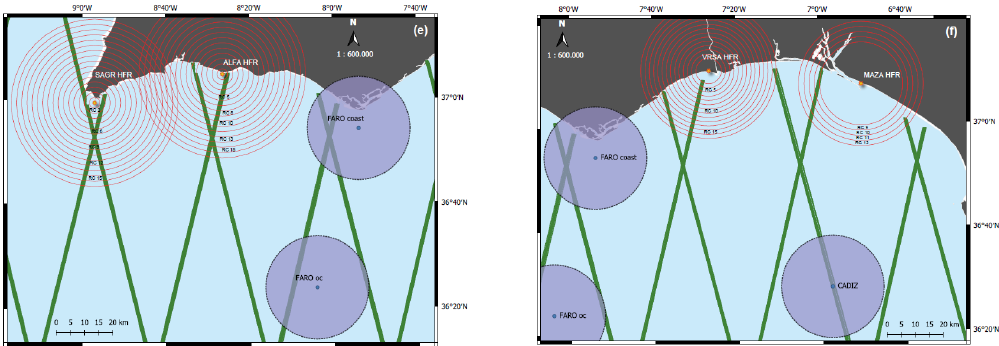
Figure 2. Wave data HFR coverage area. ( a ) VILA and FIST HFRs (RCr = 5.1 km); ( b ) PRIO HFR (RCr = 5.1 km); ( c ) SILL HFR (RCr = 5.1 km); ( d ) SJUL HFR (RCr = 1.85 km) and ESPL HFR (RCr = 2.15 km); ( e ) SAGR and ALFA HFRs (RCr = 1.85 km) and ( f ) VRSA HFR (RCr = 1.51 km) and MAZA HFR (RCr = 1.67 km). Red circles: RCs; blue dots: wave buoy locations; green lines: Sentinel-3 tracks and blue circles: 10 NM area for in situ and SA comparisons.